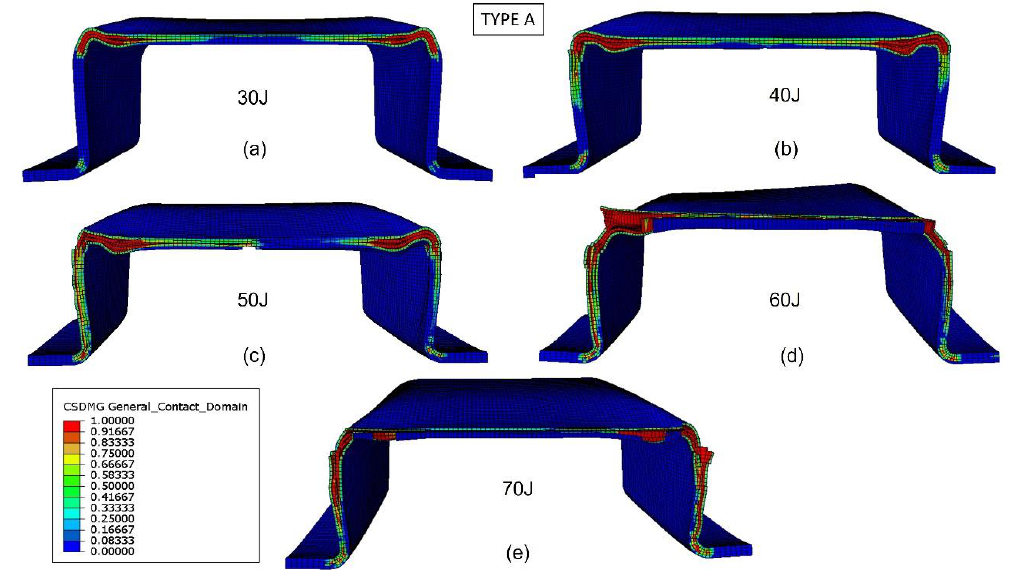
Figure 13. Delamination initiation criterion at the middle cross section of bumper beam Type A.